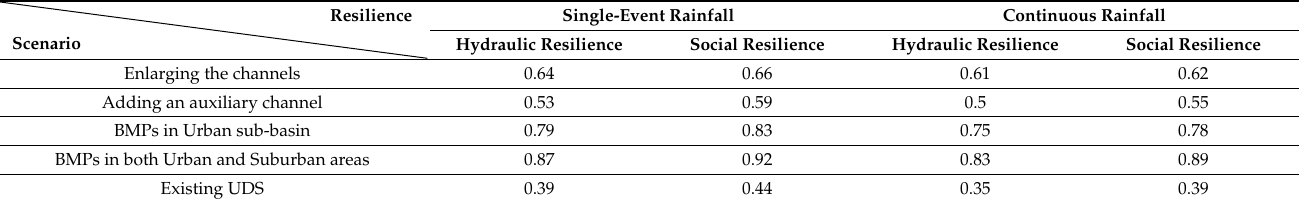
Table 7. The calculated resilience (percent) by different scenarios.